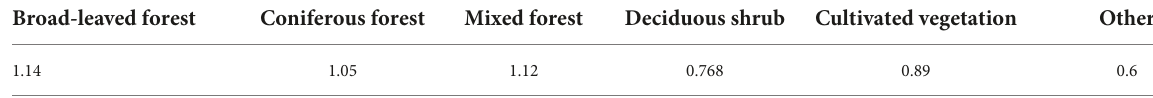
FIGURE2 The relationship between slope, aspect and ε max .